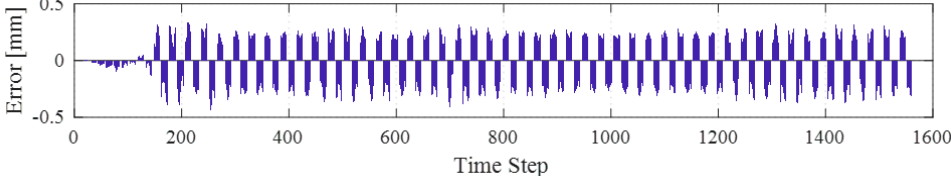
Figure 25. Difference between the exact displacement and prediction calculated at each time step for Model 1a without specimen.